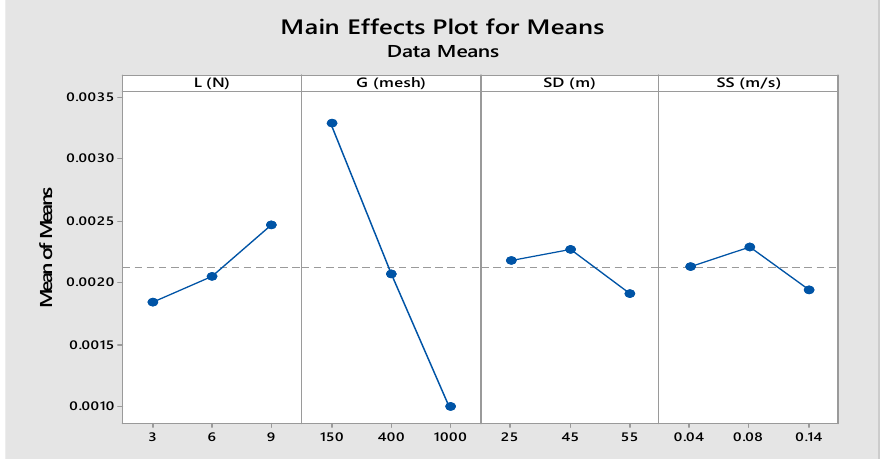
Figure 8. Main effect plot for mean volume loss of PTFE matrix composites.